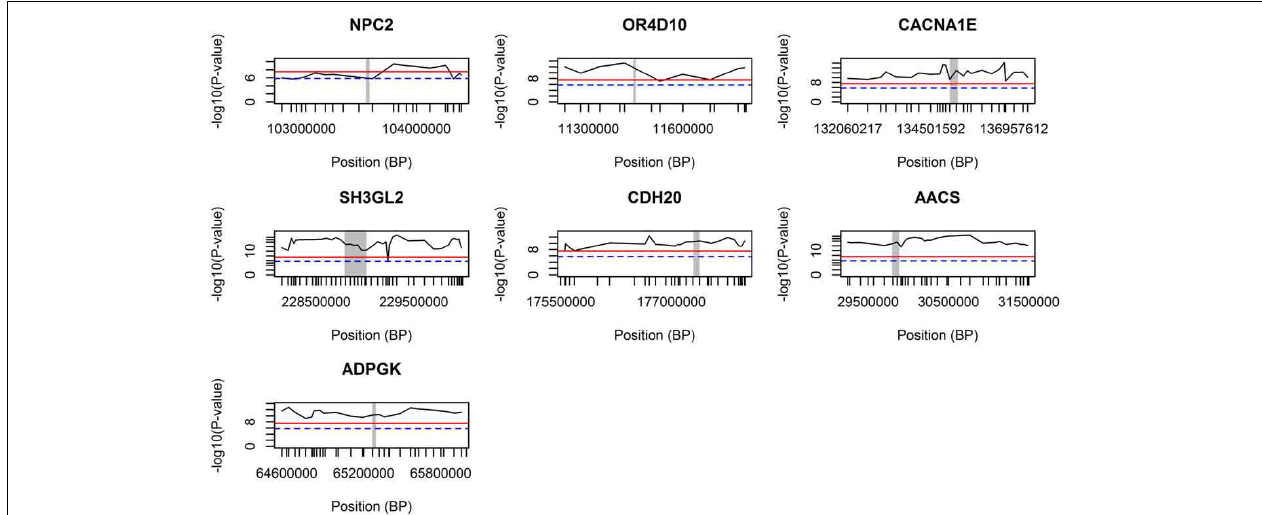
adjusted Bonferroni correction at P = 1 . 58E − 6 and the red line indicates a highly significant threshold with adjusted Bonferroni correction at P = 3 . 17E − 8 .